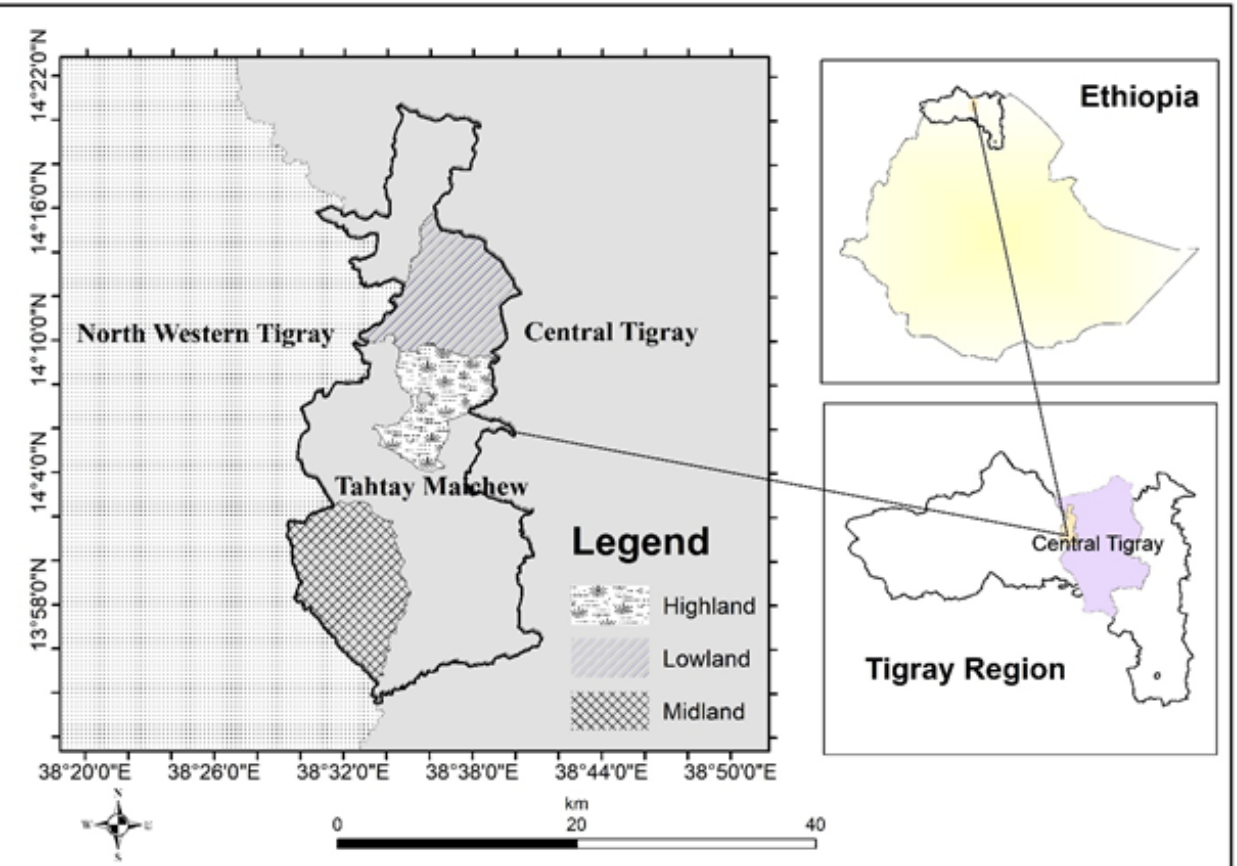
Figure 1. Map of the studied